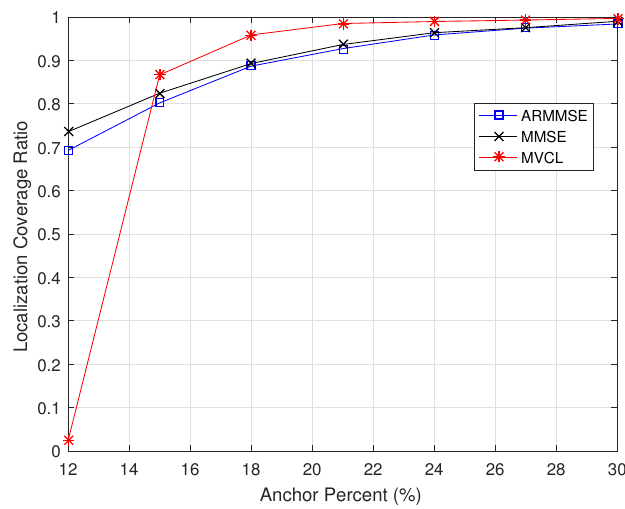
Figure 13. Localization coverage ratio with anchor percent ( n + m = 100, m = 12 30, R = 30, k = 4, ζ = 15, η = 3).